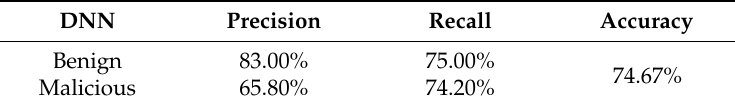
Table 5. Performance of deep neural network (DNN).